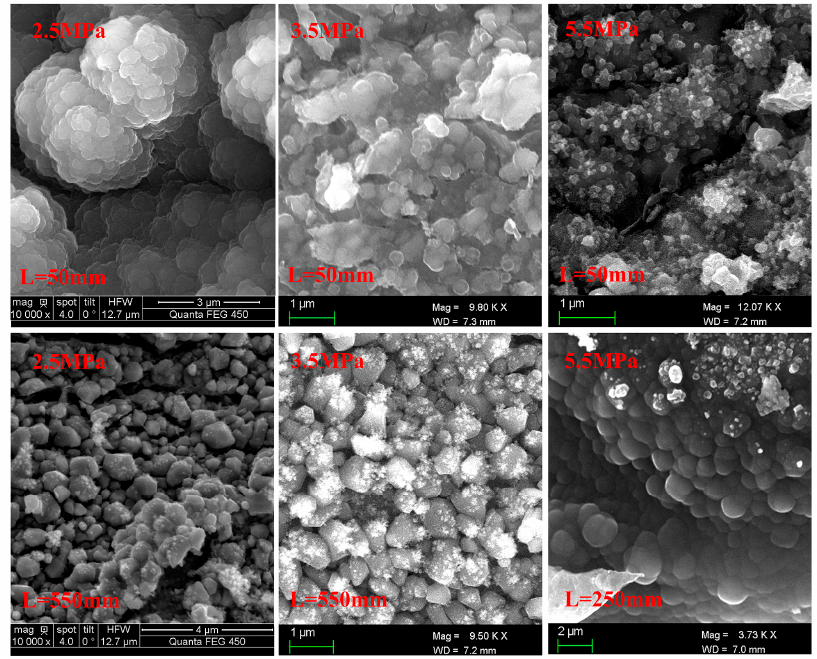
Figure 14. Morphologies of deposits under a heat flux of 0.4 MW/m 2 .